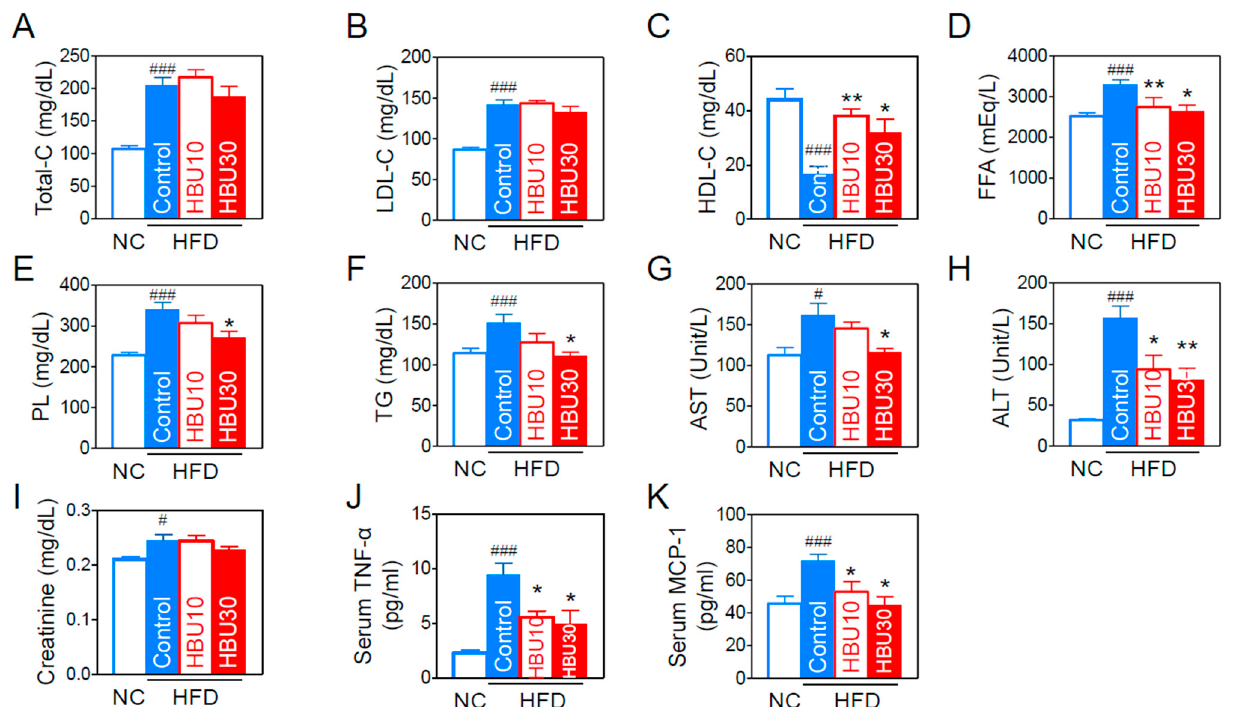
Figure 4. Effects of HBU651 on the lipid and biochemical profiles in the blood of HFD-induced obese mice. ( A ) Total-cholesterol (Total-C), ( B ) LDL-cholesterol (LDL-C), ( C ) HDL-cholesterol (HDL-C), ( D ) Free fatty acid (FFA), ( E ) Phospholipids (PL), ( F ) Triglyceride (TG), ( G , H ) Liver function marker enzyme activities of AST ( G ) and ALT ( H ), ( I ) Creatinine, ( J , K ) ELISA. Serum protein levels of TNF- α ( J ) and MCP-1 ( K ). Data are expressed as means ±SEM ( n = 5). # p < 0.05, ### p < 0.001 vs. NC, and * p < 0.05, ** p < 0.01 vs. HFD-control. NC, normal chow; Control, HFD-control; HBU10, HFD plus HBU651 10 mg/kg; HBU30, HFD plus HBU651 30 mg/kg.